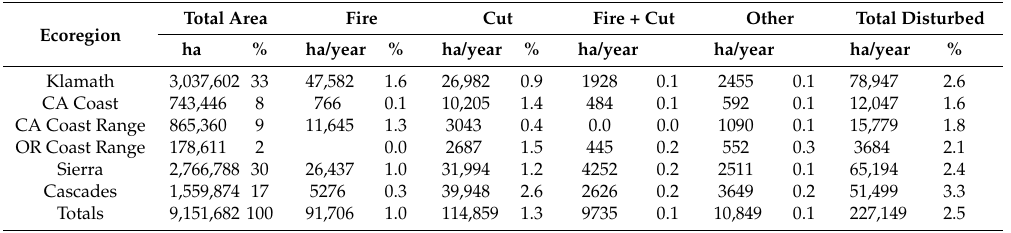
Table 2. Total area and annual rates of disturbance on forestlands in the study area between times 2 and 3, by ecoregion